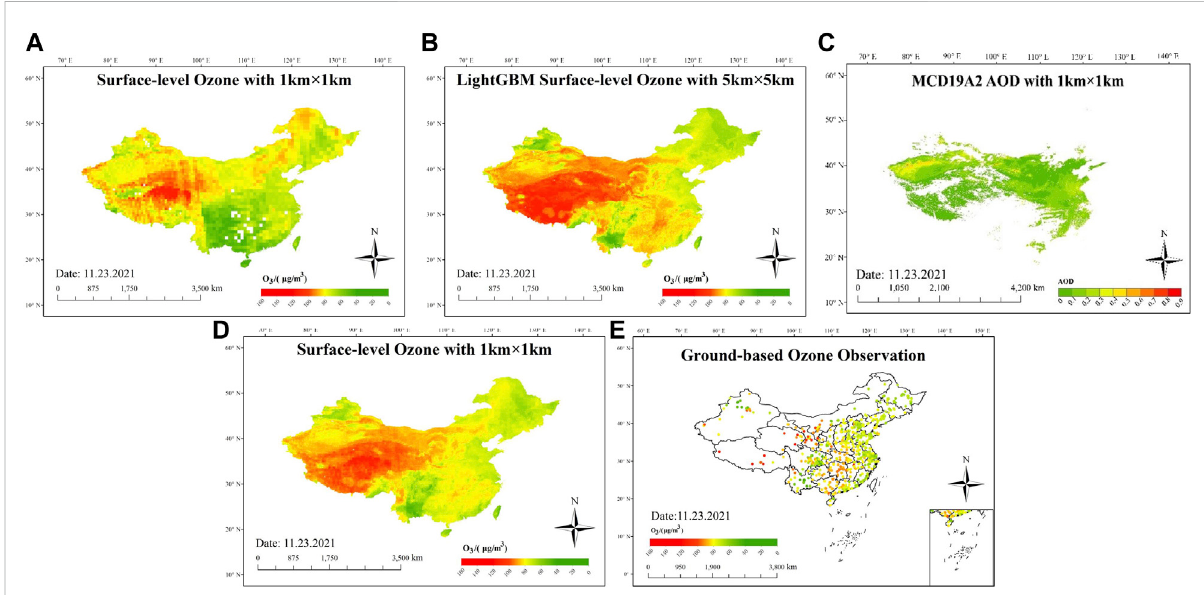
FIGURE 7 DownscaledresultbasedontheMImethod. (A) 30 kmTROPOMIsurfaceO 3 concentrationimage, (B) 5 kmLightGBMsurfaceO 3